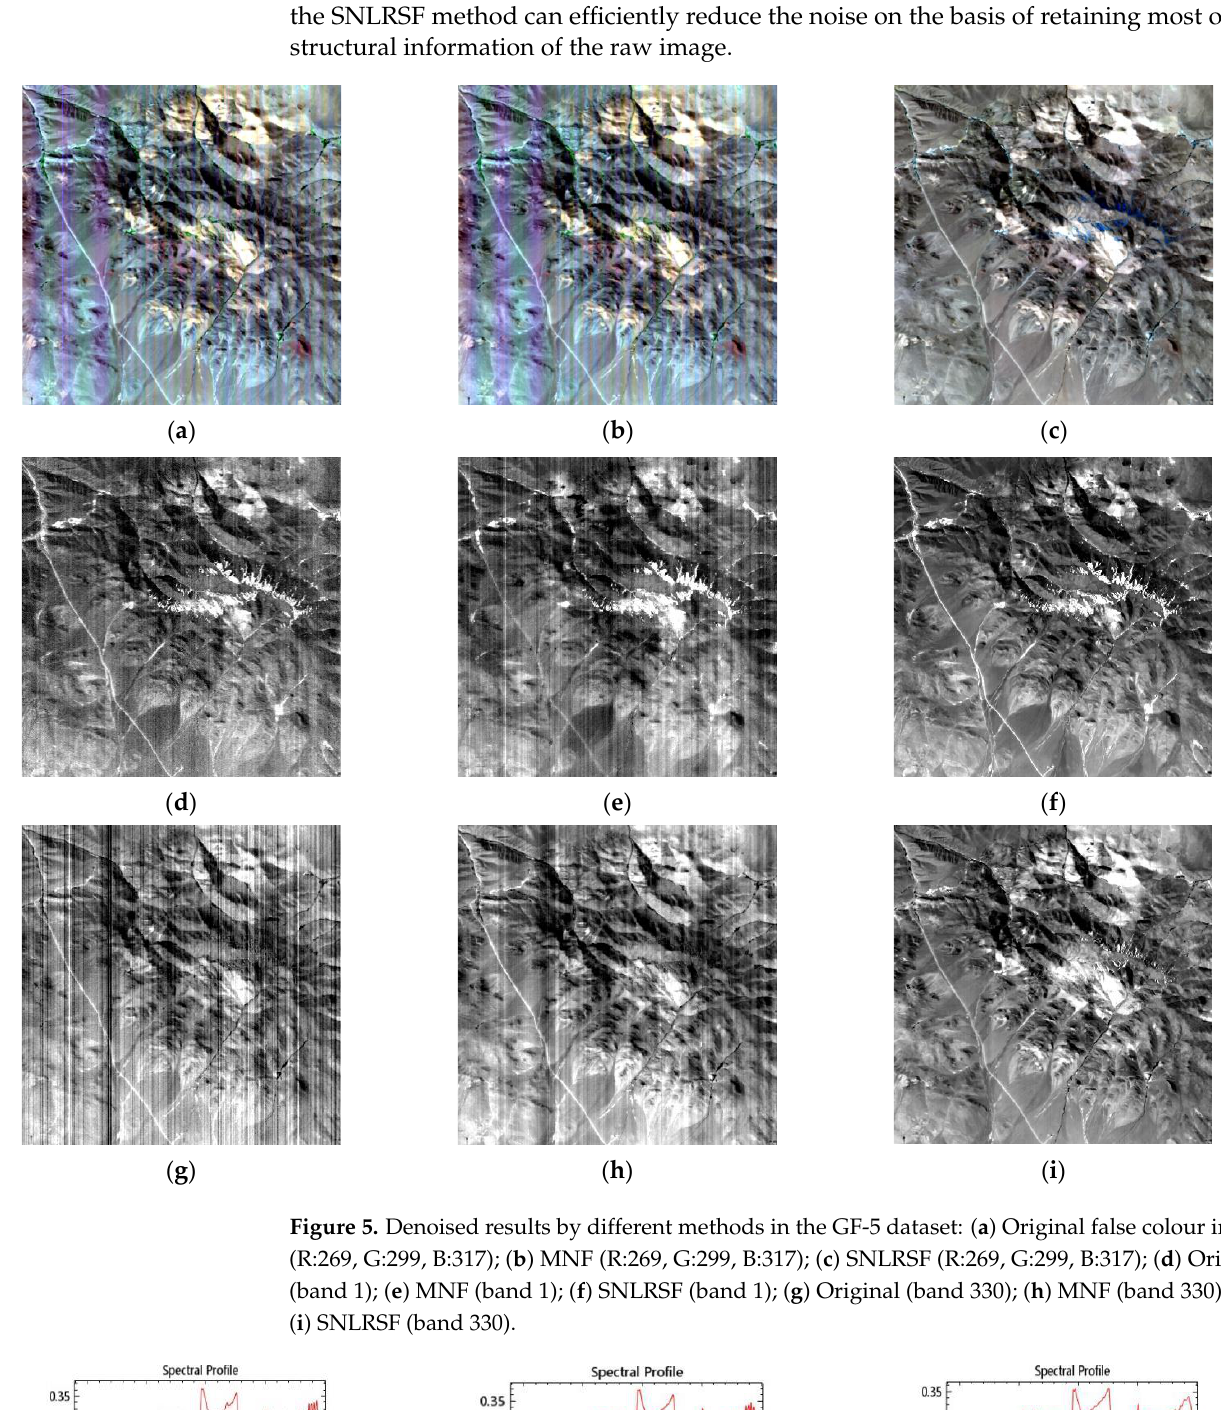
10 of 26 Figure 4. Two components of the designed 1-D CNN model construction: ( a ) The architecture of the dataset; and ( b ) The structure of the specific network, * represents the convolutional operation per- formed on the input data with the convolution filter. 4. Results 4.1. Denoised GF-5 HSIs The SNLRSF method was employed to denoise the GF-5 image compared with the traditional method: minimum noise fraction (MNF) [56]. The MNF method was employed to rotate the original GF-5 image to choose the first 30 bands. The former 30 bands were retained for the inverse MNF rotation to obtain hyperspectral imagery with 300 bands. The noisiest parts of GF-5 are in the SWIR band, so false colour bands (R:269, G:299, B:317)